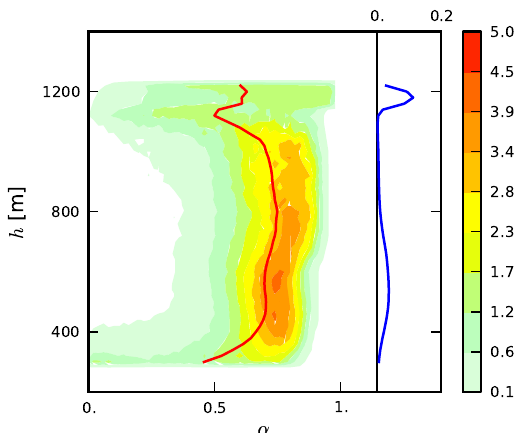
the stratocumulus top), respectively. Values of the character- istic time scales are indicated by colors and black isolines.